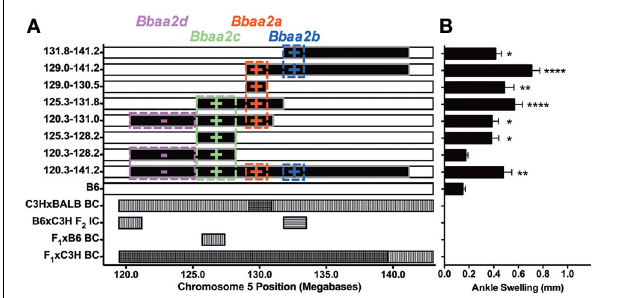
FIGURE 4 | Regulatory loci identified by analysis of advanced congenic lines, modified from Bramwell et al. (2014). (A) Each of the top 8 horizontal bars represents one B6.C3H- Bbaa2 sub-interval congenic mouse line. The horizontal axis represents the position of Bbaa2 on mouse Chromosome 5 (120.3–141.2Mb). The black portions of each row are derived from the C3H genetic background and the white portions are derived from the B6 background. Colored boxes indicate the position boundaries and predicted effect ( + / − ) of multiple regulatory intervals identified by advanced congenic lines. The lower 4 rows indicate arthritis severity QTL intervals predicted by Roper et al. (2001) for the backcross/intercross populations listed on the left vertical axis. Horizontal hatching denotes QTL for ankle swelling, vertical hatching denotes QTL for histopathology or tendon sheath thickening, cross hatching denotes overlap of multiple predicted QTL. (B) Ankle swelling measurements for the eight congenic lines listed in A, with significance assessed relative to B6 negative control. ∗ P < 0 . 05, ∗∗ P < 0 . 01, ∗∗∗∗ P < 0 .